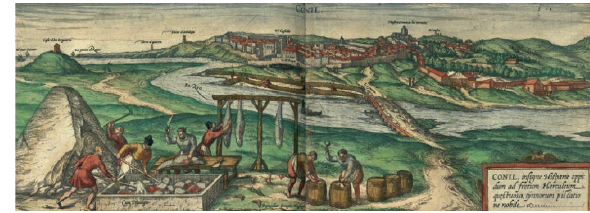
Figure 7. View of Conil de la Frontera from the 17th century.